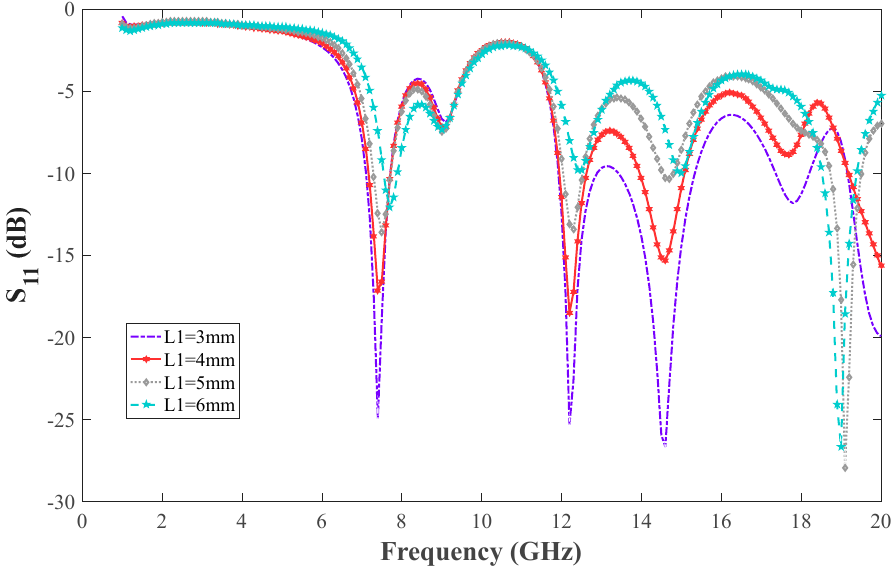
Figure 3. Estimation of the feed line for the proposed antenna.